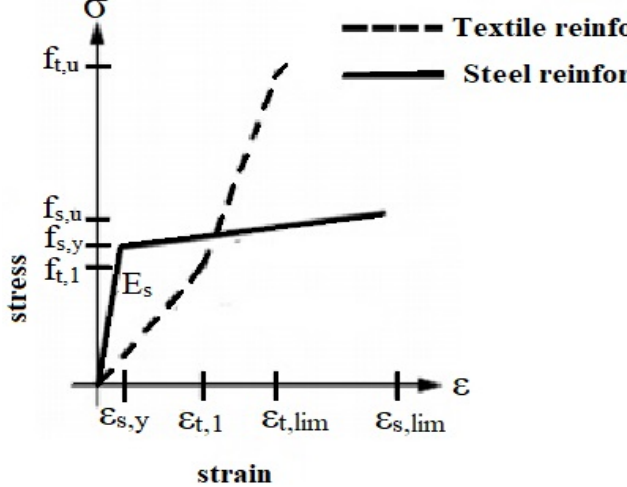
Figure 7. Tensile behavior of steel and carbon textile reinforcements [56].